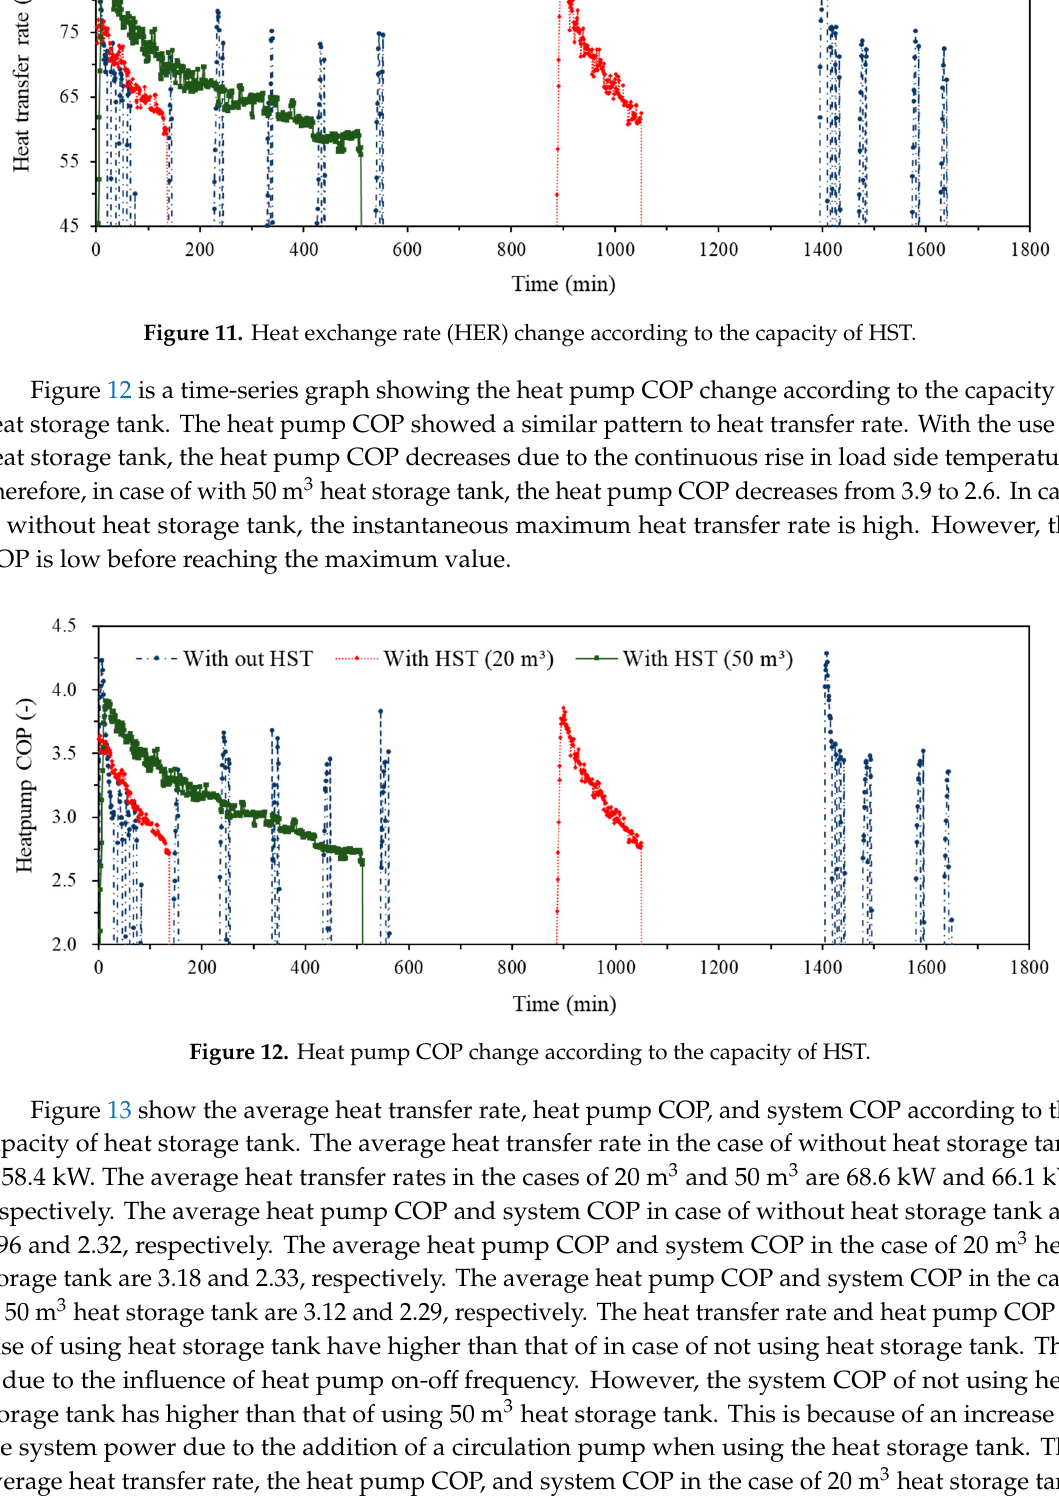
Figure 12. Heat pump COP change according to the capacity of HST.